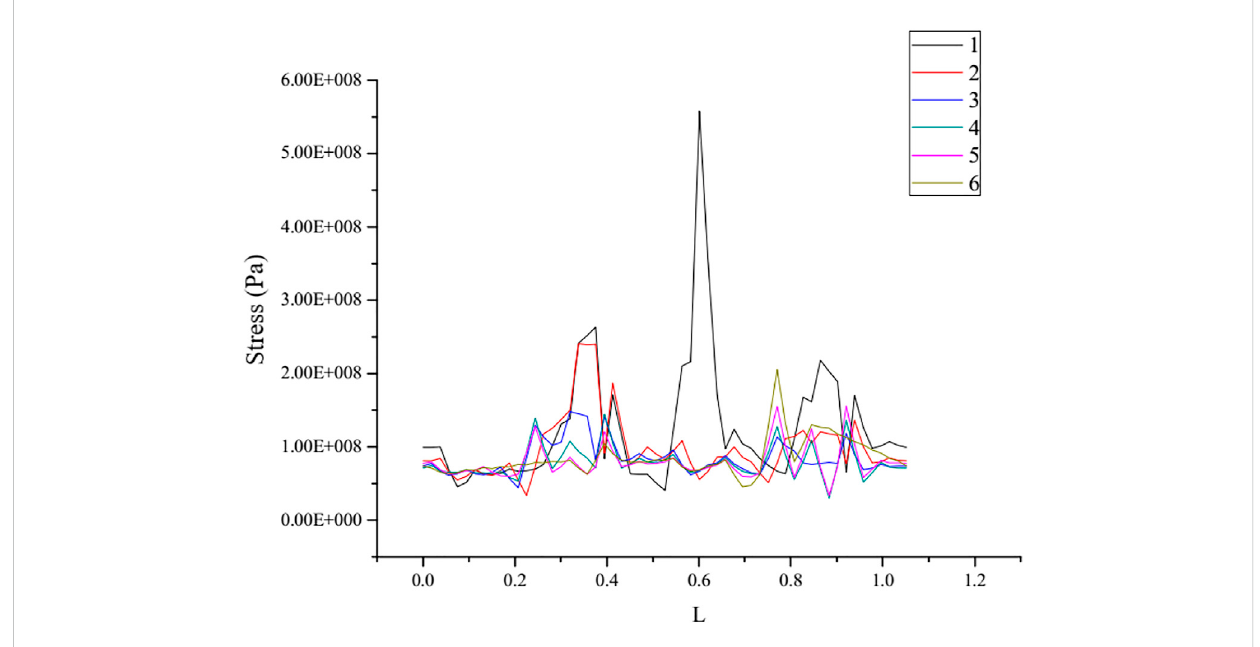
FIGURE 15 Circumferential stress distribution of cross sections of each ring.